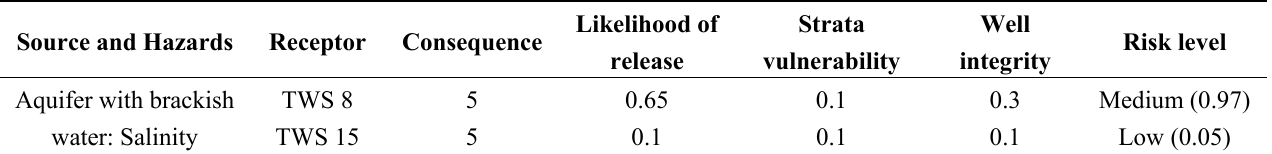
Table 6. Summary of risk assessment for town water supply TWS 8 and TWS 15.